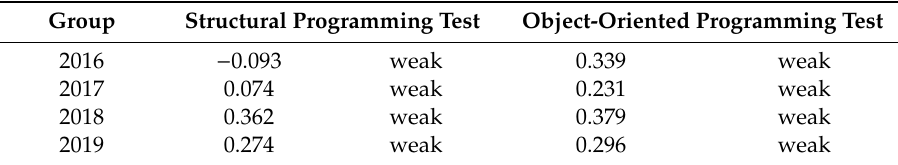
Table 13. Pearson correlation coe ffi cient between results of entrance admission process and grades of tests in individual experimental